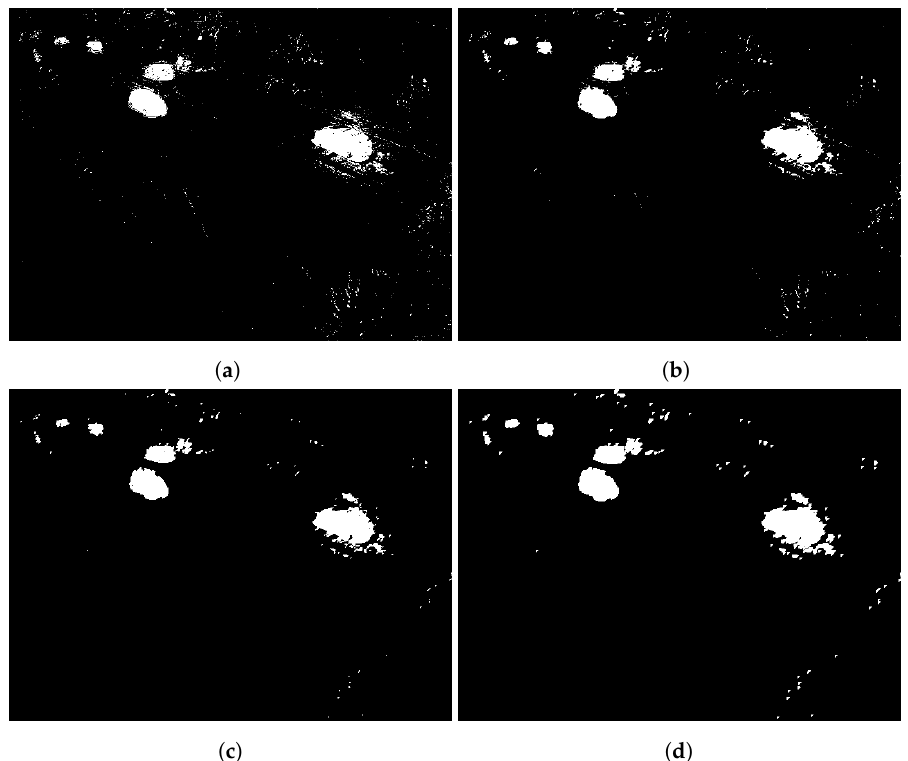
Figure 3. ( a ) Background layer with no filter applied; ( b ) opening filter applied to remove background noise; ( c ) closing filter applied to fill object gaps; ( d ) dilate filter applied to join adjacent objects.